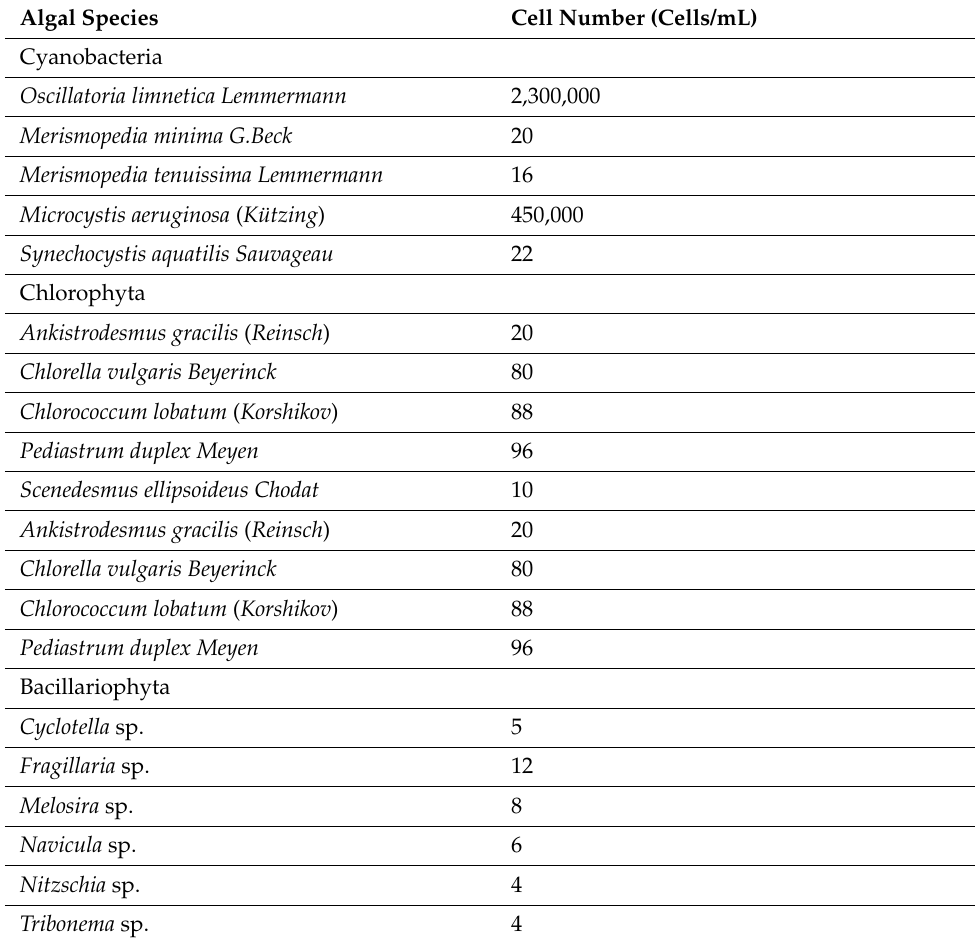
Table 1. Cell density (cell mL − 1 ) of phytoplankton present in water samples used in irrigation of crop plants ( Eruca sativa and Lactuca sativa ).